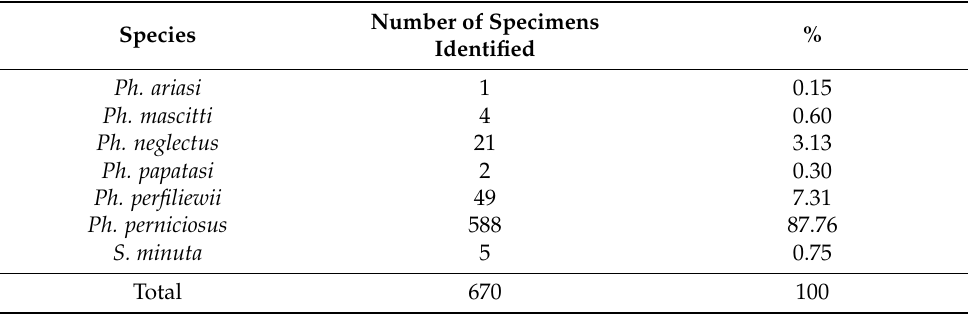
Table 2. Species and number of Phlebotomine sand flies collected per site typology. Number of Number of Number of Species Specimens in WND Specimens in Specimens in Sites Leishmania Sites Collebeato Village Ph. perniciosus 164 340 84 Ph. perfiliewi 39 5 5 Ph. neglectus 2 0 19 Ph. mascittii 1 1 2 Ph. papatasi 2 0 0 S. minuta 4 1 0 Ph. ariasi 0 0